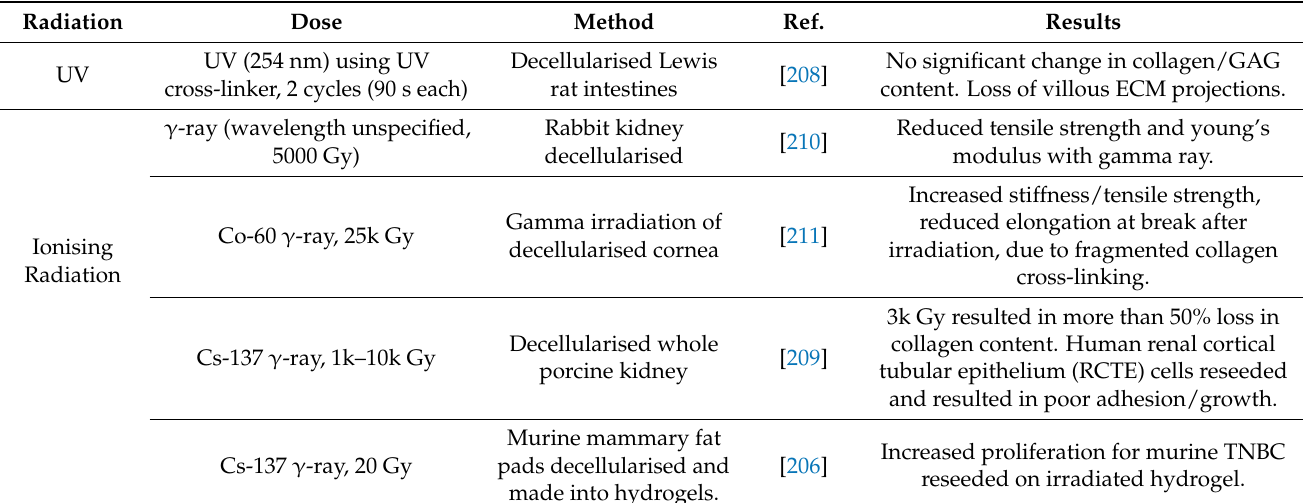
Table 3. Decellularised tissues exemplify a highly representative ECMs that can mimic key asepcts of in vivo responses to radiation damage. Studies using these systems show that X-rays have a higher propensity than UVR to induce changes in mechanical properties of ECM scaffolds, and that X-ray exposure can affect subsequent cell responses to the ECM. Radiation Dose Method Ref.